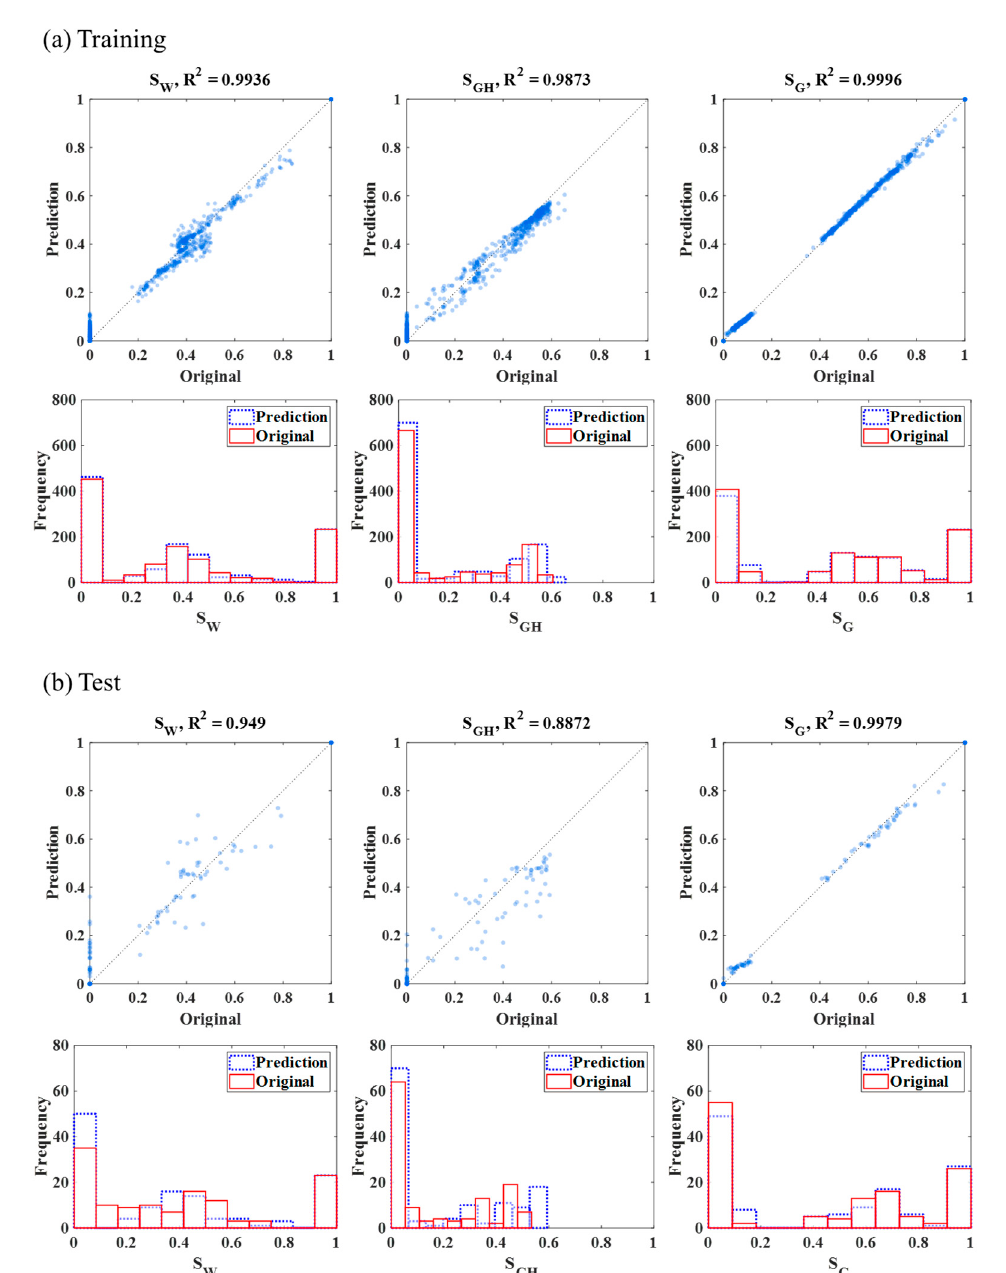
Figure 12. ( a ) Training and ( b ) test results of Case 4, each column means each saturation, water, gas hydrate, and gas with coefficient of determination. In the scatter plots, the X and Y axes indicate the given original data and the predicted value by random forest, respectively. In the histogram pictures, the X and Y axes mean each saturation and frequency, respectively.